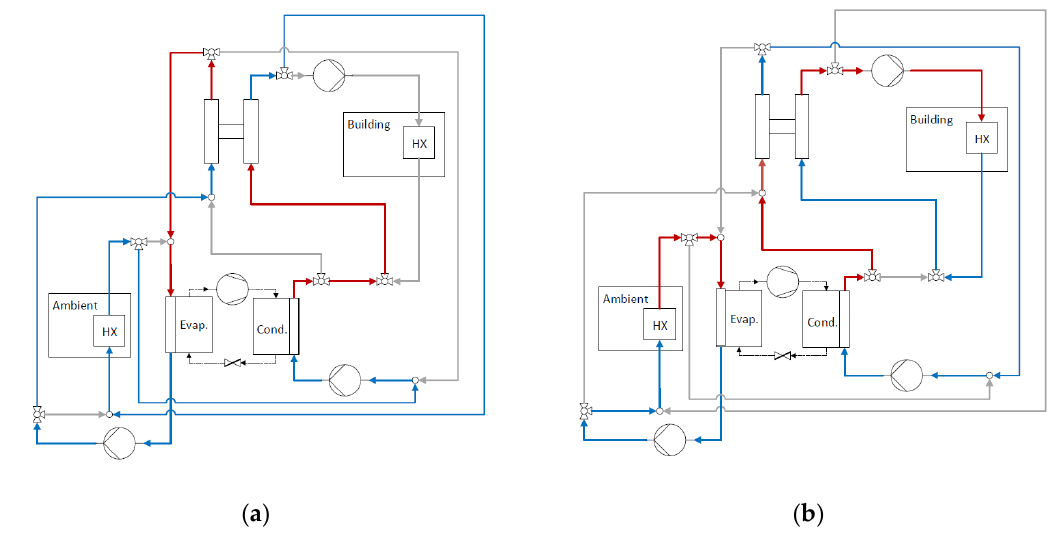
Figure 2. Schematic of the sorption storage integration together with a compression heat pump, where the H-shaped component represents the HMX: ( a ) Charging mode: Heat pump provides high temperature for desorption and low temperature for condensation; ( b ) Discharging mode: Heat pump provides low temperature heat for evaporation.